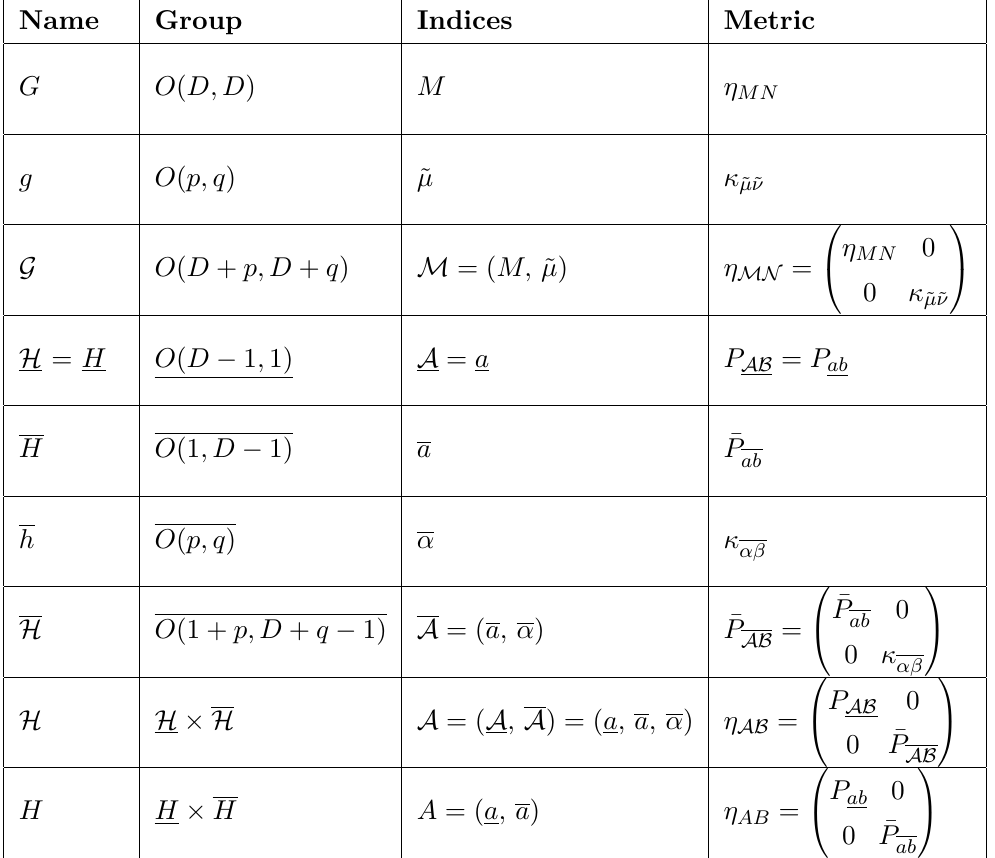
Table 1 . Groups, metrics and index structure for the extended space relevant to heterotic DFT.